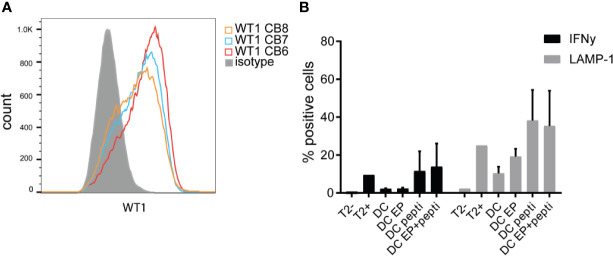
WT1 expression and presentation. (A) Intracellular WT1 levels measured by flow cytometry after electroporation of WT1 mRNA compared to isotype control (grey). Validation runs 6–8 are shown. (B) Percentage of intracellular IFNg levels and extracellular LAMP-1 expression by WT1-specific CD8 T-cells activated by cord blood-derived dendritic cells (CBDC) electroporated with WT1 mRNA (DC EP), loaded with peptivator (DC pepti), both (DC EP+pepti) or nothing (DC). T2 cells in the presence or absence of peptide served as controls. 2 CBDC donors were used. Statistical analysis is performed in GraphPad Prism using Kruskal-Wallis test, no significant differences.